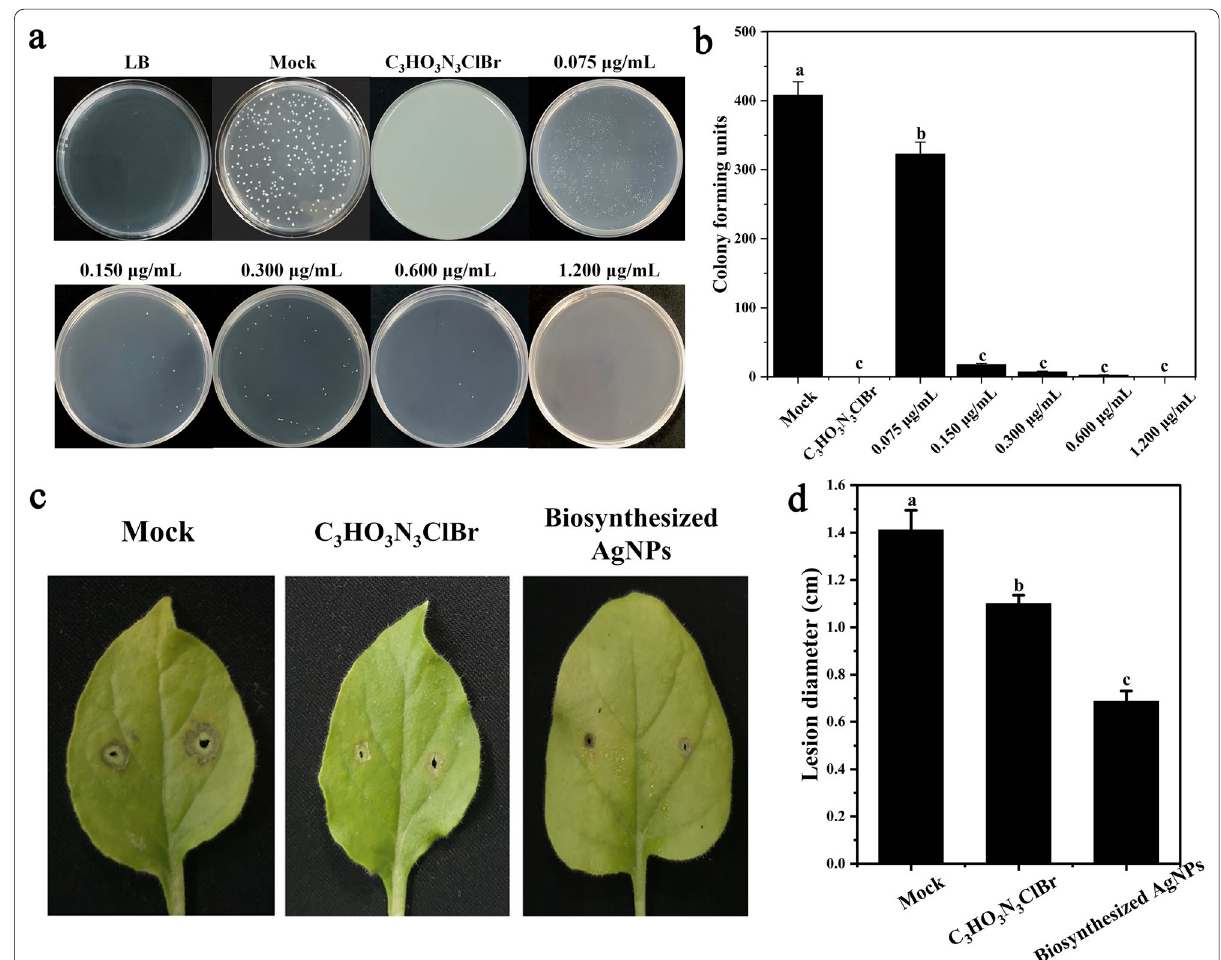
Fig. 2 Antibacterial activity of biosynthesized AgNPs in vitro and in vivo. a In vitro inhibitory effect of biosynthesized AgNPs at different concentrations against Pseudomonas syringae pv. tabaci . b Column diagram showing bacterial colony numbers on LB media containing different concentrations of biosynthesized AgNPs. c Symptoms of tobacco wildfire disease on Nicotiana benthamiana leaves pretreated with 1.2 μg/mL biosynthesized AgNPs. d Column diagram showing the size of lesions caused by P. syringae pv. tabaci in c . Mock, negative control (treated with sterilized distilled water). The data are mean standard error ( n 3). Different lowercase letters indicate significant difference in ANOVA univariate ± = analysis (LSD test, P <